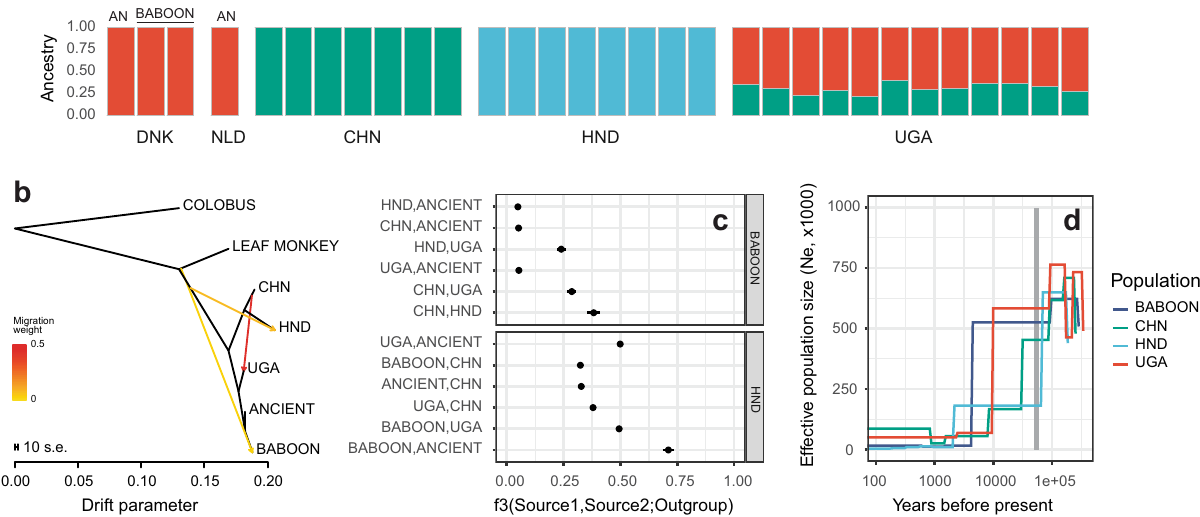
Fig. 3 Fine-scale genetic relationships and admixture between global populations. a Admixture plot depicting population ancestry proportions determined using NGSadmix (K = 3, variants = 484,914). See Supplementary Fig. 6 for a complete analysis of K from 2 to 10. Ancient (AN) and baboon samples are highlighted. b Treemix maximum likelihood tree of ancient and modern samples, including Colobus and Leaf monkey samples as outgroups, showing three migration edges. See Supplementary Fig. 8 for a complete analysis of migration edges from 0 to 5. c Outgroup f 3 statistics were determined using qp3Pop in ADMIXTOOLS to compare allele frequency correlations between two source populations (indicated on the left side of the panel) relative to an outgroup population (right side of the panel). f 3 values ( f 3 = [ f outgroup - f source1 ]*[ f outgroup - f source2 ], where f is the allele frequency, averaged over all variable sites) are indicated by a point and whiskers represent the standard error, calculated using a weighted block jackknife (2,575,411 SNPs; n = 3 blocks; default parameters). For all data presented, the Z score was signi fi cant (|Z| > 3). d The population demographic history of each population was determined using SMC ++ to compare effective population size (Ne) over recent evolutionary history. The grey vertical box highlights the period between 50 and 60 thousand years ago, coinciding with the migration of modern humans out of Africa. Sample abbreviations: CHN = China; UGA = Uganda; HND =